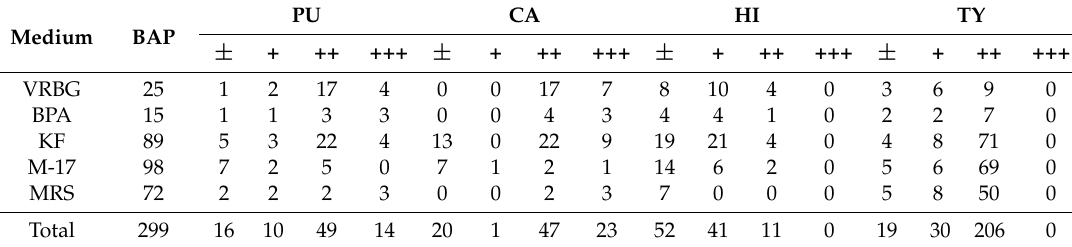
Table 4. Biogenic amine forming capacity of bacteria isolated from goat´s and ewe’s milk cheeses according to the culture media. High hydrostatic pressure (HHP) treatments to which cheese samples were subjected are not